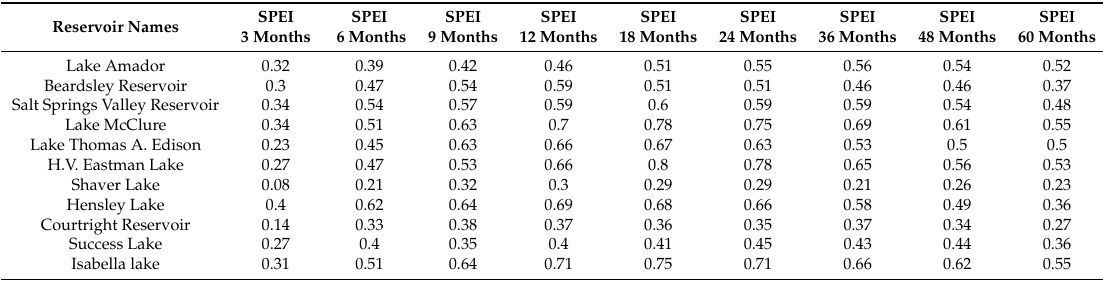
Table 1. Pearson’s correlations for multiscalar SPEI for reservoirs inside San Joaquin drainage. Reservoir